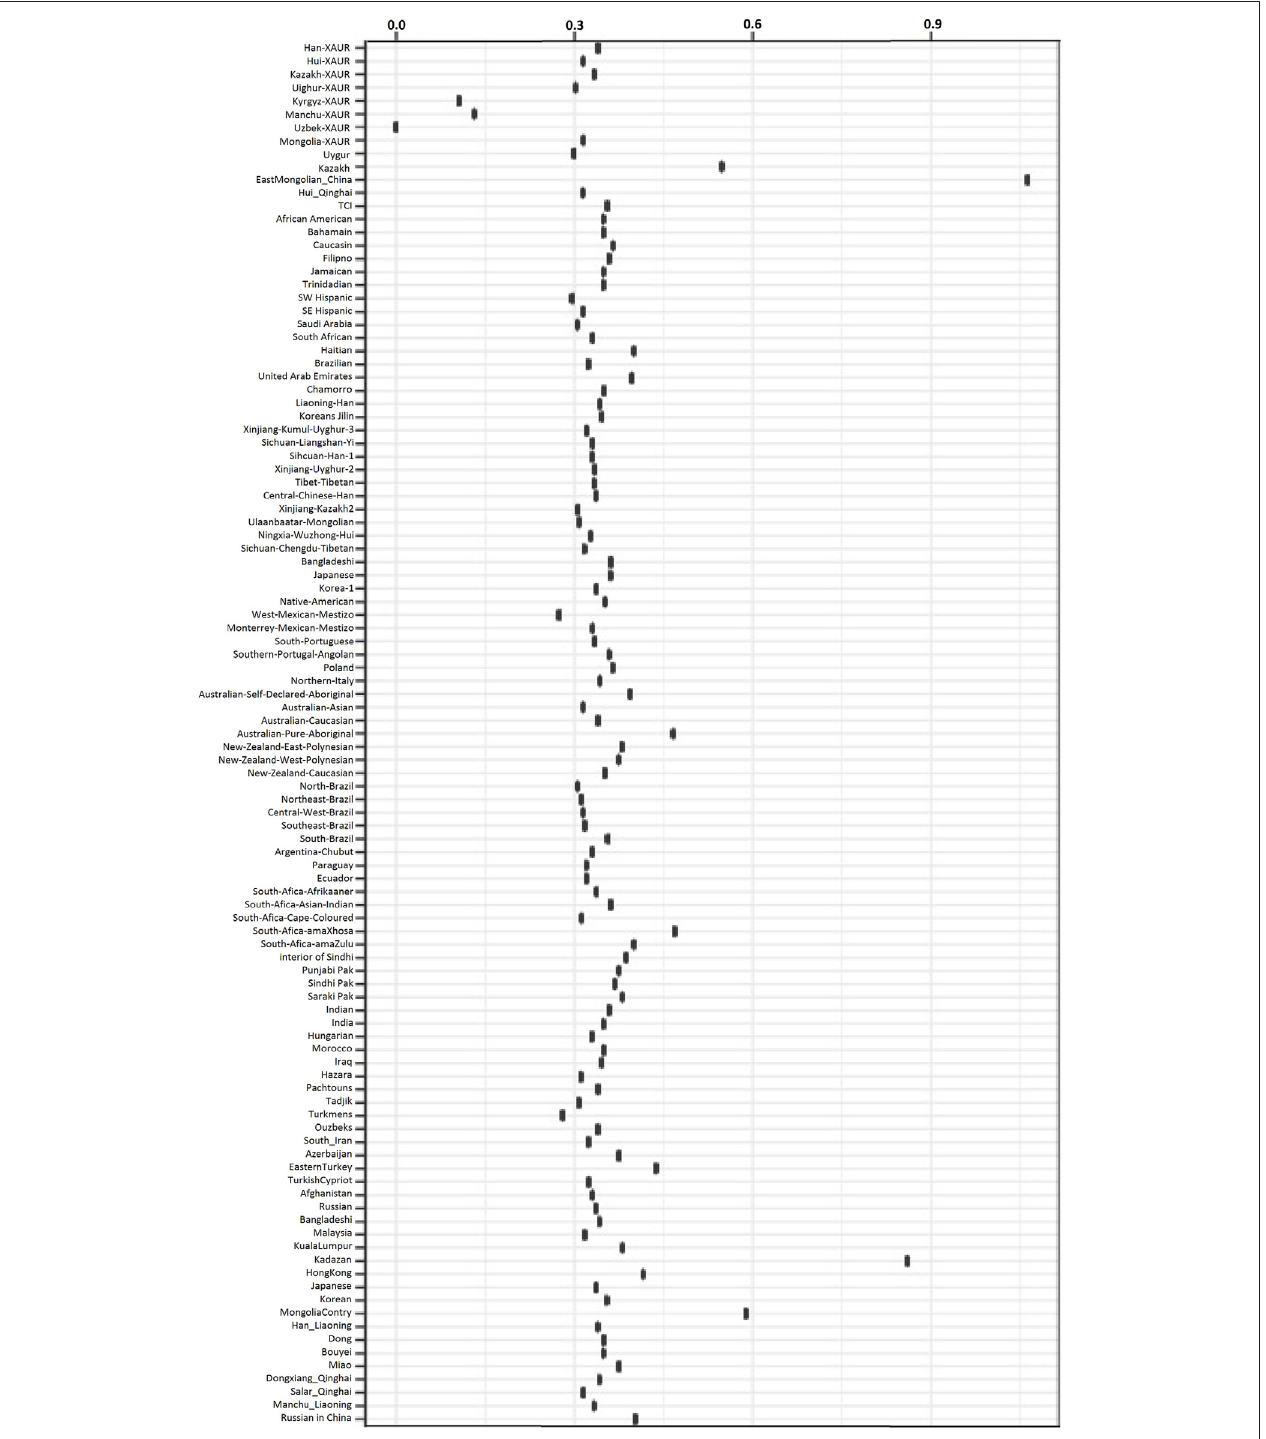
FIGURE 7 | Interactivity test between the Xinjiang Han population and 104 other reference populations from worldwide.